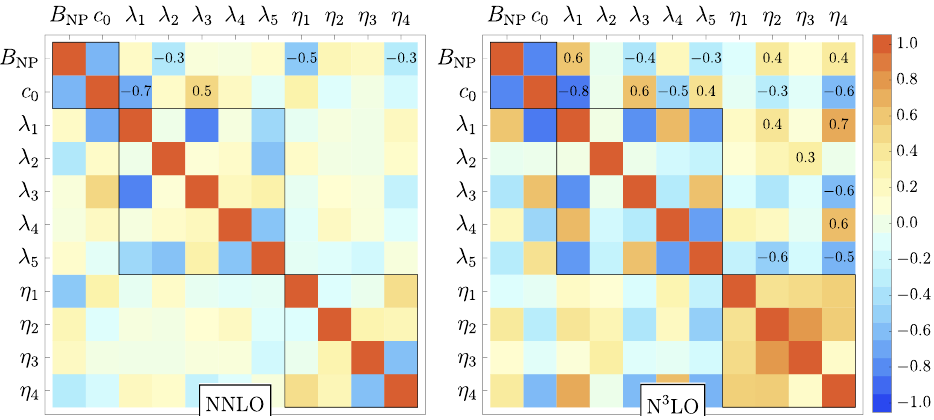
Figure 22 . The correlation matrices for NP parameters obtained in the global (cid:12)t of DY and SIDIS. Numbers indicate the values of matrix elements with correlation higher then 0 : 3.